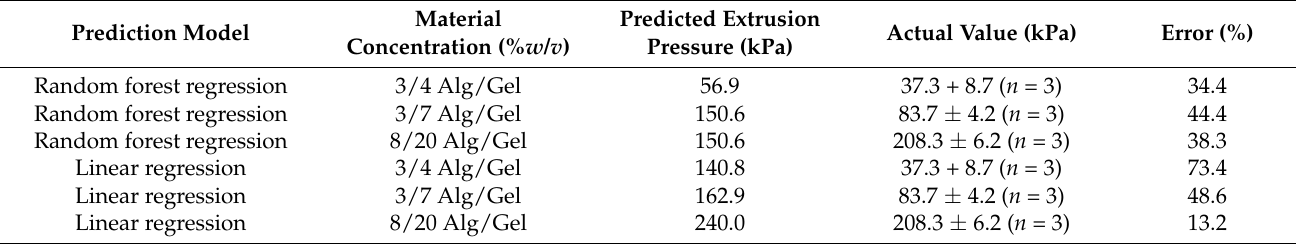
Table 3. Predicted extrusion pressure required to deposit material are compared against experimental values for corre- sponding material concentrations of alginate and gelatin. Actual values represent the mean ± standard deviation for all samples ( n = number of